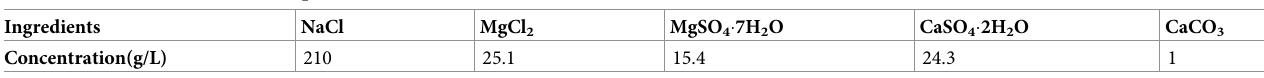
Table 6. Concentration of each component of 15% salt